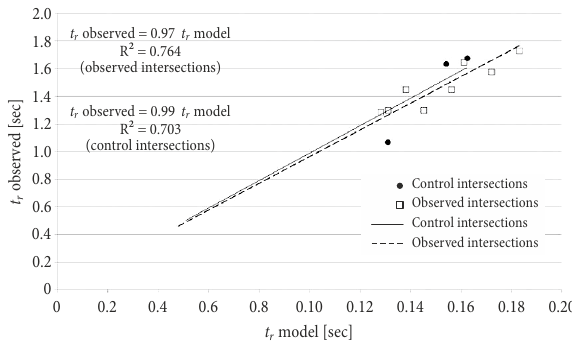
Fig. 6. Comparison of model results averages for each